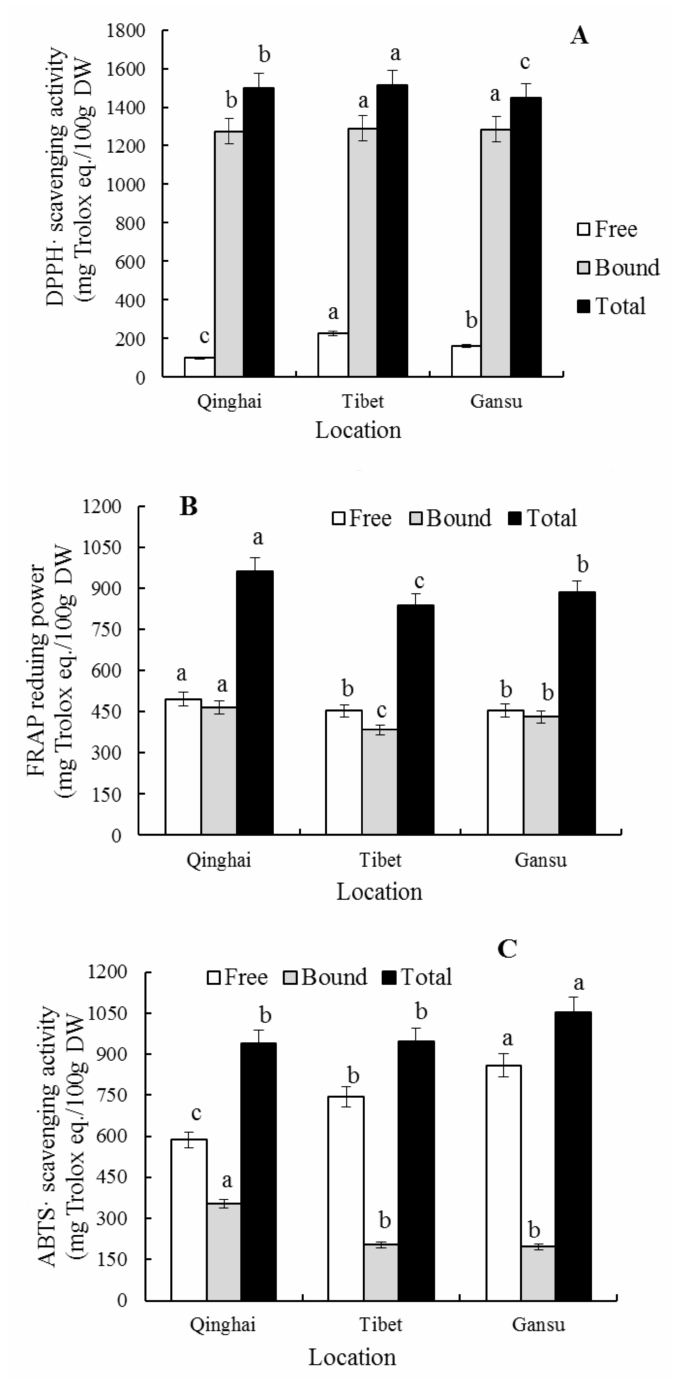
Figure 3. Analysis of the antioxidant activity of blue highland barley from different locations. ( A ) DPPH radical scavenging activity; ( B ) FRAP reducing power; ( C ) ABTS • + scavenging activity. Different letters denote significant difference at the level p <